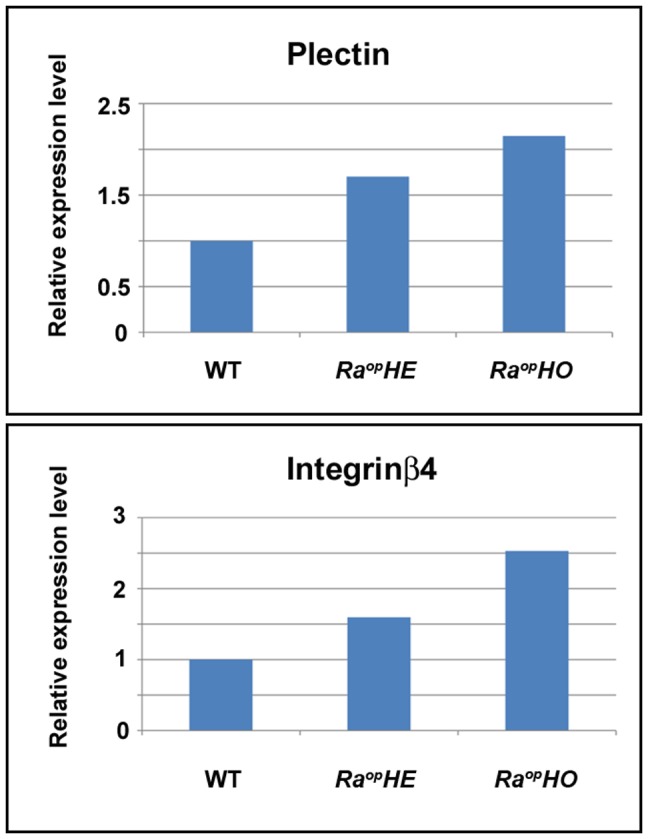
mRNA level in Raop mice.Quantitative PCR analysis of Plectin (upper) and integrin β4 (lower) expression level. RaopHE; heterozygous Raop mice. RaopHO; homozygous Raop mice.